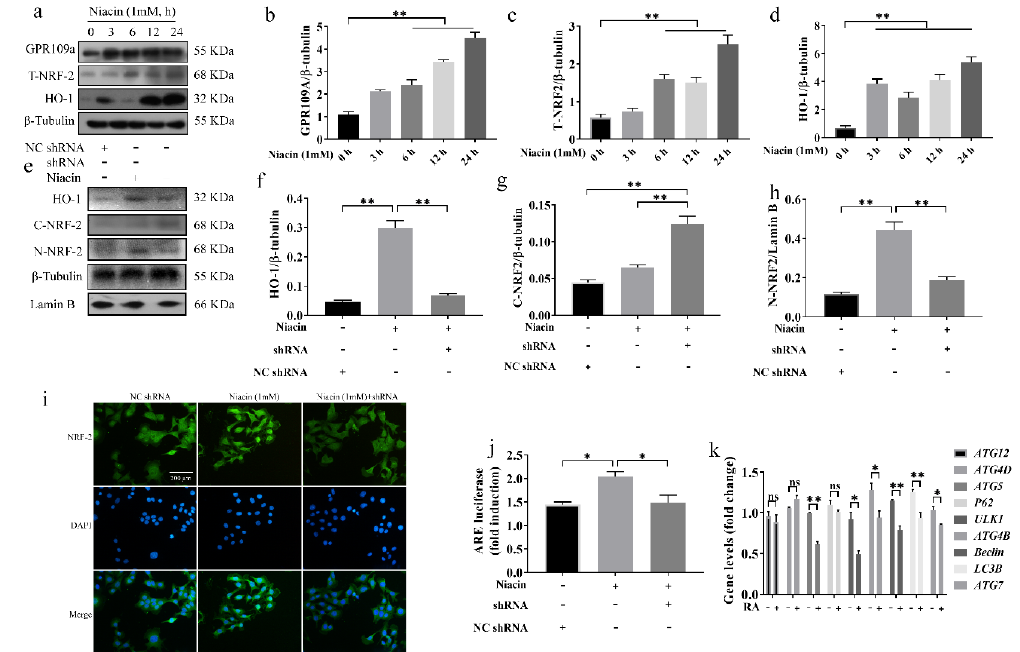
Figure 3. Niacin can activate the GPR109A/NRF2/autophagy signal pathway. The cells were collected at 0, 3, 6, 12, and 24 h to extract the total protein. The total protein was prepared and subjected to Western blotting using GPR109A, NRF-2, HO- 1, and β -tubulin antibodies. T-NRF-2 means total